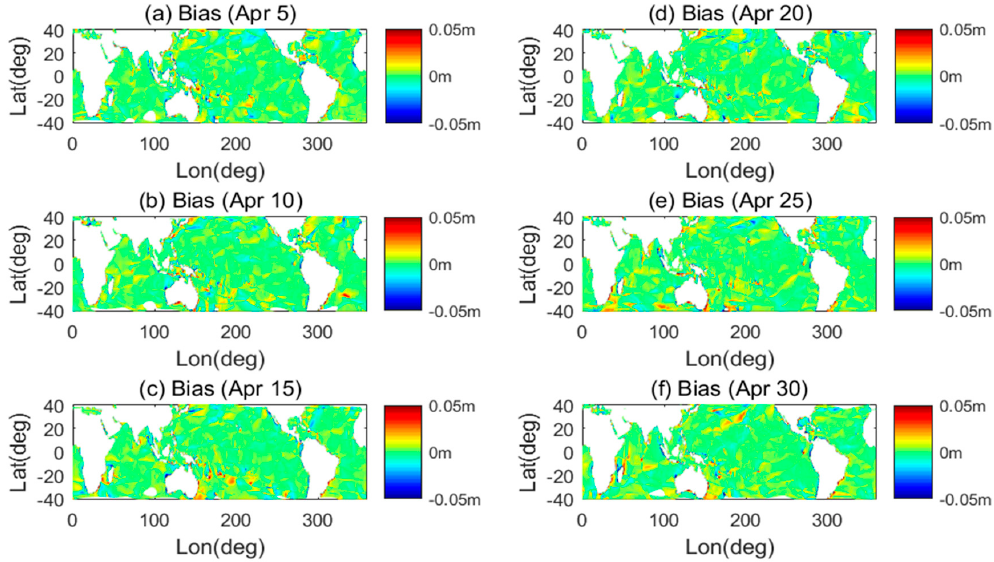
Figure 9. Residual distribution of CYGNSS SWH estimates in April 2017.